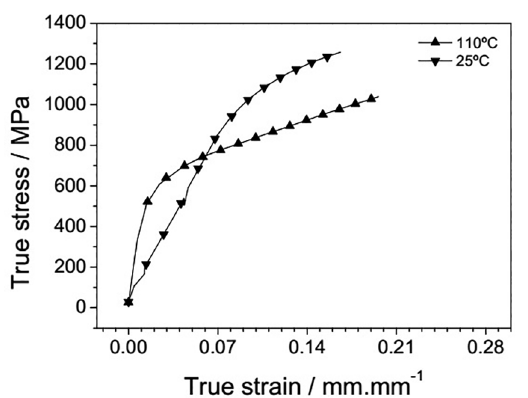
Figure 6. True stress-strain curves at 25 °C for the wire drawn at 25 and 110 °C with 0.21 mm 2 .mm -2 area